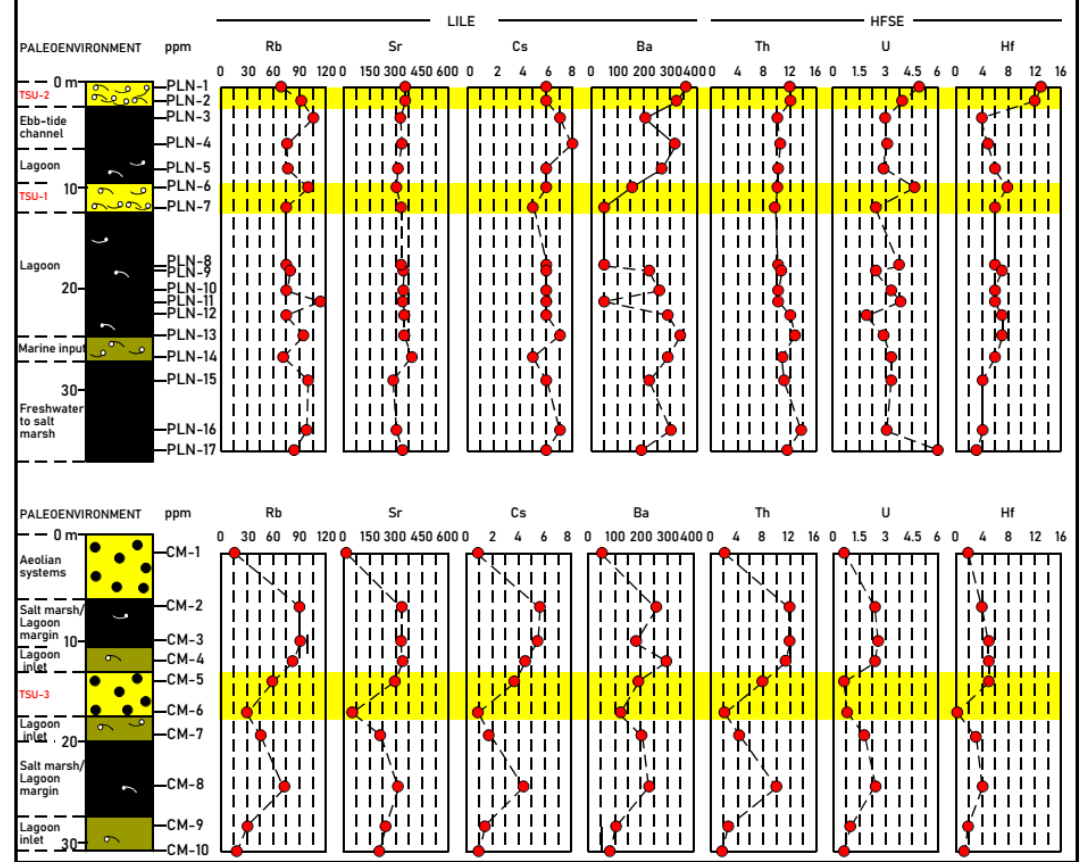
Figure 5. Vertical variations (in ppm) of large-ion lithophile elements (LILEs) and high field strength elements (HFSEs). The detection limits are 15 ppm (Rb), 1 ppm (Sr), 1 ppm (Cs), 50 ppm (Ba), 0.2 ppm (Th), 0.5 ppm (U) and 1 ppm (Hf).